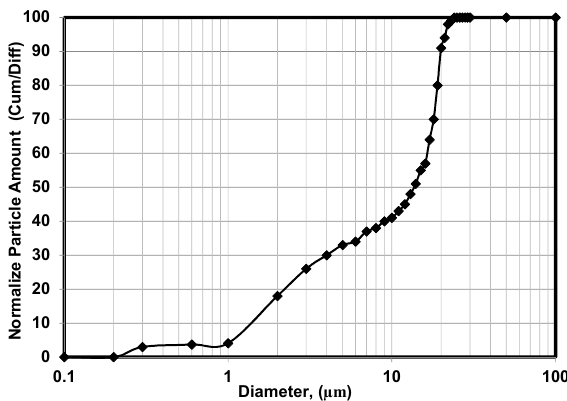
Figure 6. Oil droplet size distribution of artificially produced oil-in-water emulsion.